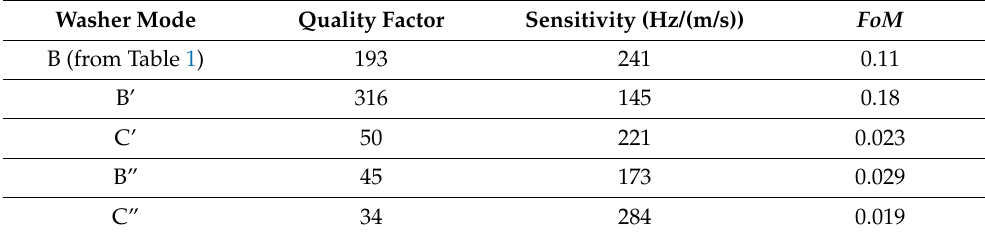
Figure 7. Spectra representation evaluated from ( a , c ) the transmission region at the outside and ( b , d ) on the washer surface. Table 3. Quantitative characteristics of the acoustic liquid